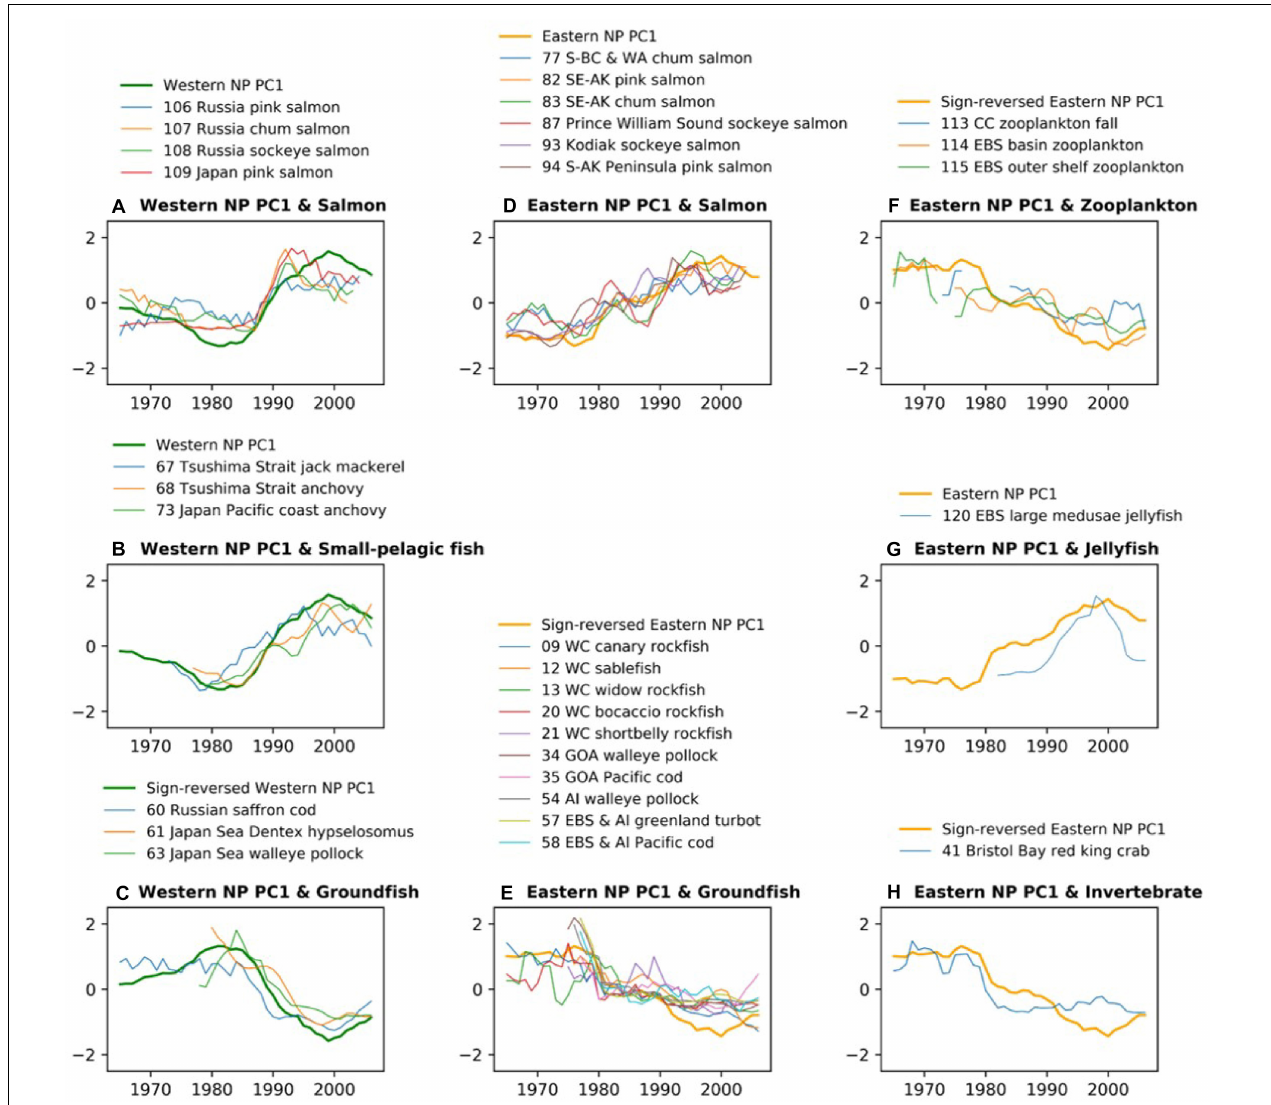
FIGURE 3 | Time-series comparison between marine biological PC1 and biological time series that have significant correlations with that PC1 in each basin shown in Figures 2B,C . The time series of western NP (A) salmon, (B) small pelagic fish, and (C) groundfish are shown along with the western NP PC1. The time series of eastern NP (D) salmon, (E) groundfish, (F) zooplankton, (G) jellyfish, and (H) invertebrate are shown along with eastern NP PC1. All time series are smoothed by 5-year running mean. For an easier comparison, the PC1 time series are sign-reversed (multiplied by –1) for (C,E,F)